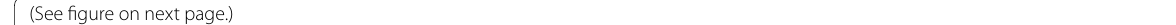
Fig. 4 Examples of overestimated intracranial arterial stenosis on DLIR images. ASIR-V ( a , e ), DLIR-L ( b , f ), DLIR-M ( c , g ), DLIR-H ( d–h ) of a 69-year-old woman ( a – d ) and a 71-year-old male ( e – h ) with cerebral atherosclerosis are shown. 80% ASIR-V and DLIR images show similar depiction of the proximal and distal cerebral arteries. Moderate-to-severe focal stenosis at segment A3 of right anterior cerebral artery and segment P3 of right posterior cerebral artery are noticed (black arrow). The residual lumens at the stenosis are clearly visible in the ASIR-V images, while in the high-level DLIR image, residual lumens are